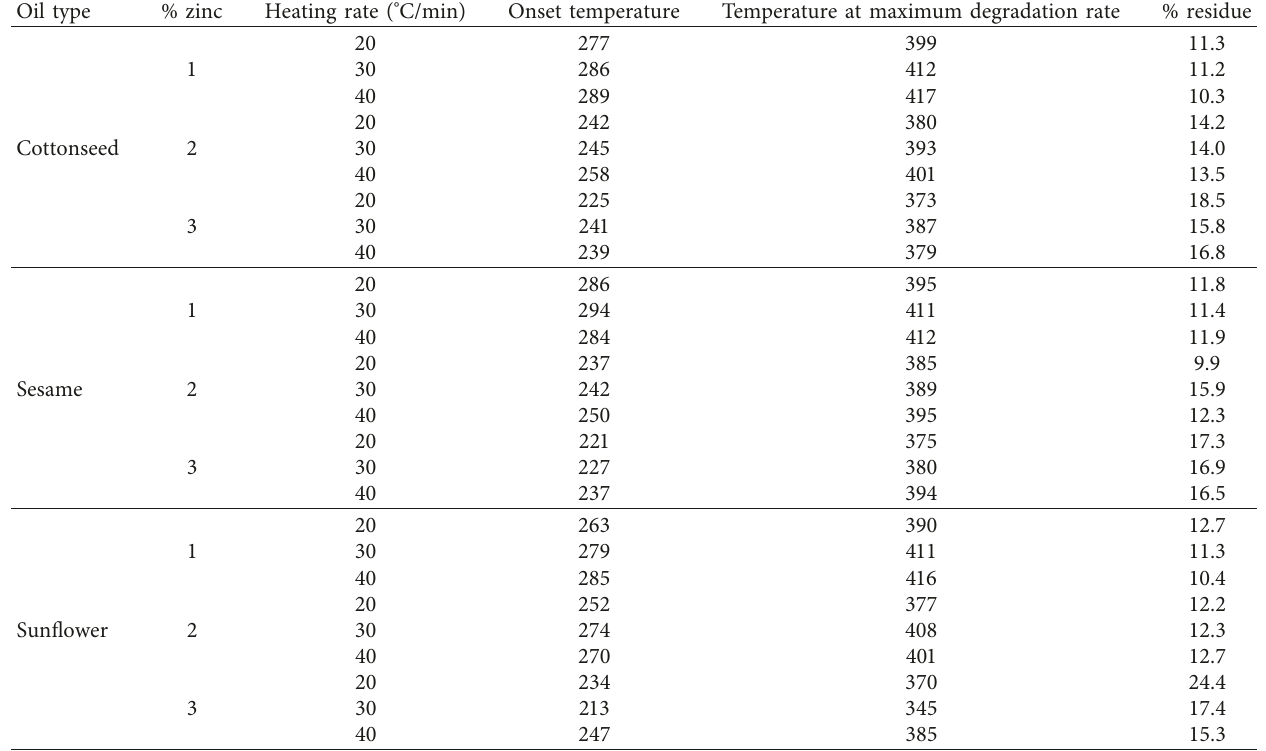
Table 2: Degradation onset and temperature at the maximum degradation rate of millet flour-based epoxy resin. Oil